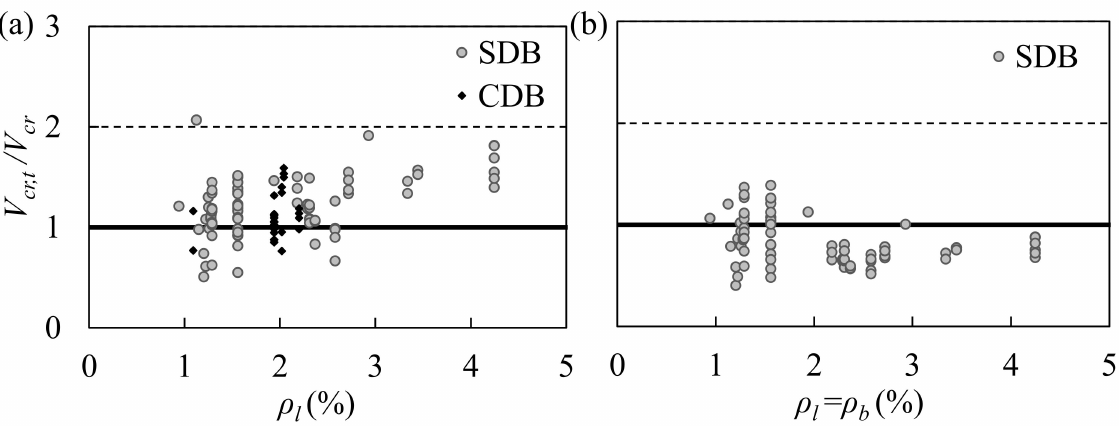
Figure 5. Diagonal tension cracking strength according to longitudinal bar ratio. ( a ) Birrcher’s model [18]; ( b ) Kim’s model